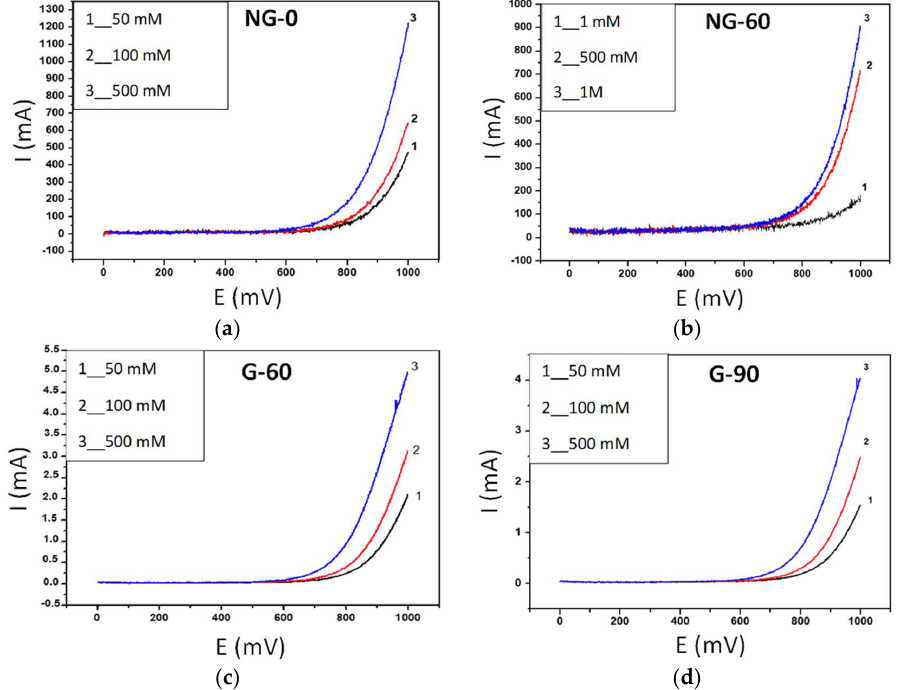
Figure 3 Figure 3. Linear sweep voltammetry of the ( a ) NG-0; ( b ) NG-60; ( c ) G-60 and ( d ) G-90 films, in the presence of different concentrations of H 2 O 2 in 0.1 M PBS solution (pH